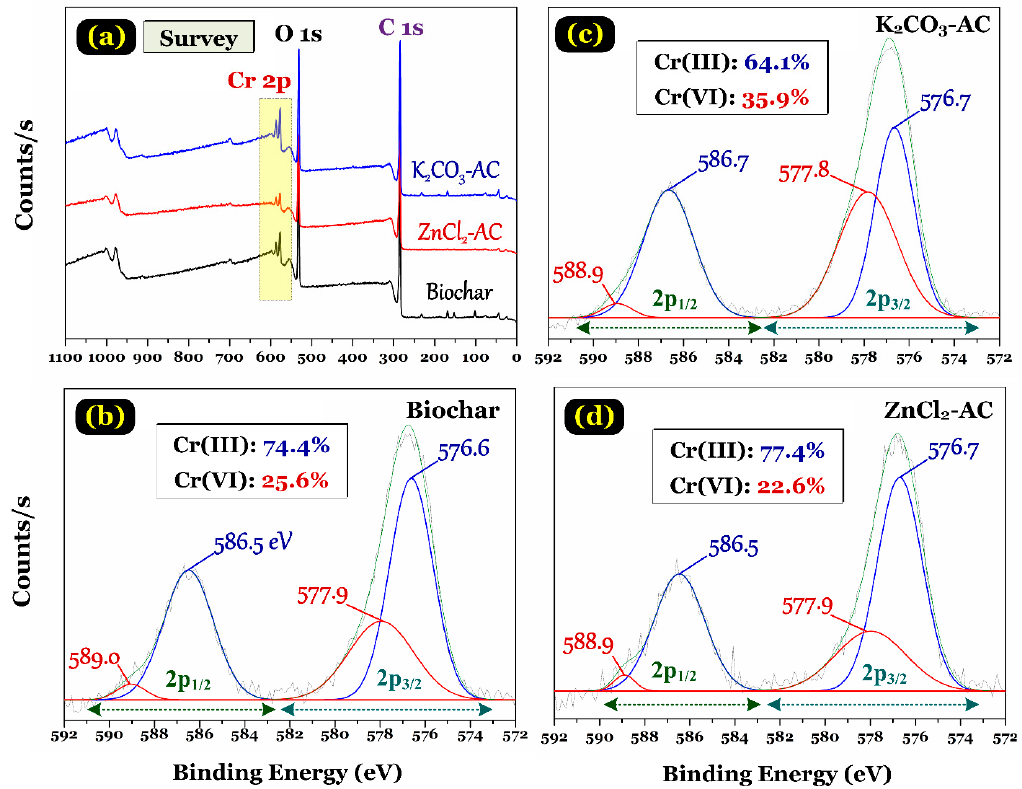
Figure 5. ( a ) X-ray photoelectron spectroscopy (XPS) survey spectrum of the prepared biochar and two activated carbon samples, and ( b )–( d ) high-resolution spectrum of Cr 2p in these samples. (Note: the initial Cr(VI) concentration is approximately 200 mg/L).